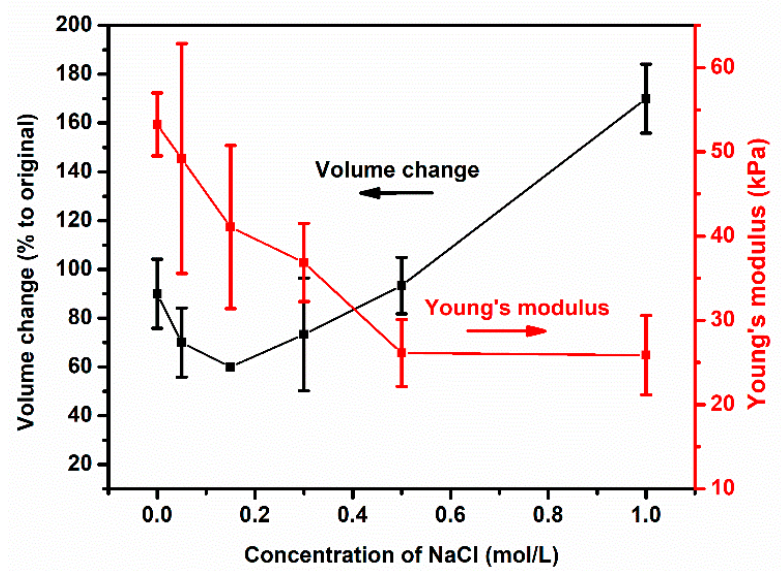
Figure 4. E ff ect of NaCl concentration on the volume change and Young (cid:48) s modulus (5%–10% strain) Figure 4. Effect of NaCl concentration on the volume change and Young ′ s modulus (5%–10% strain) of of pTMAEMA-PA-1.